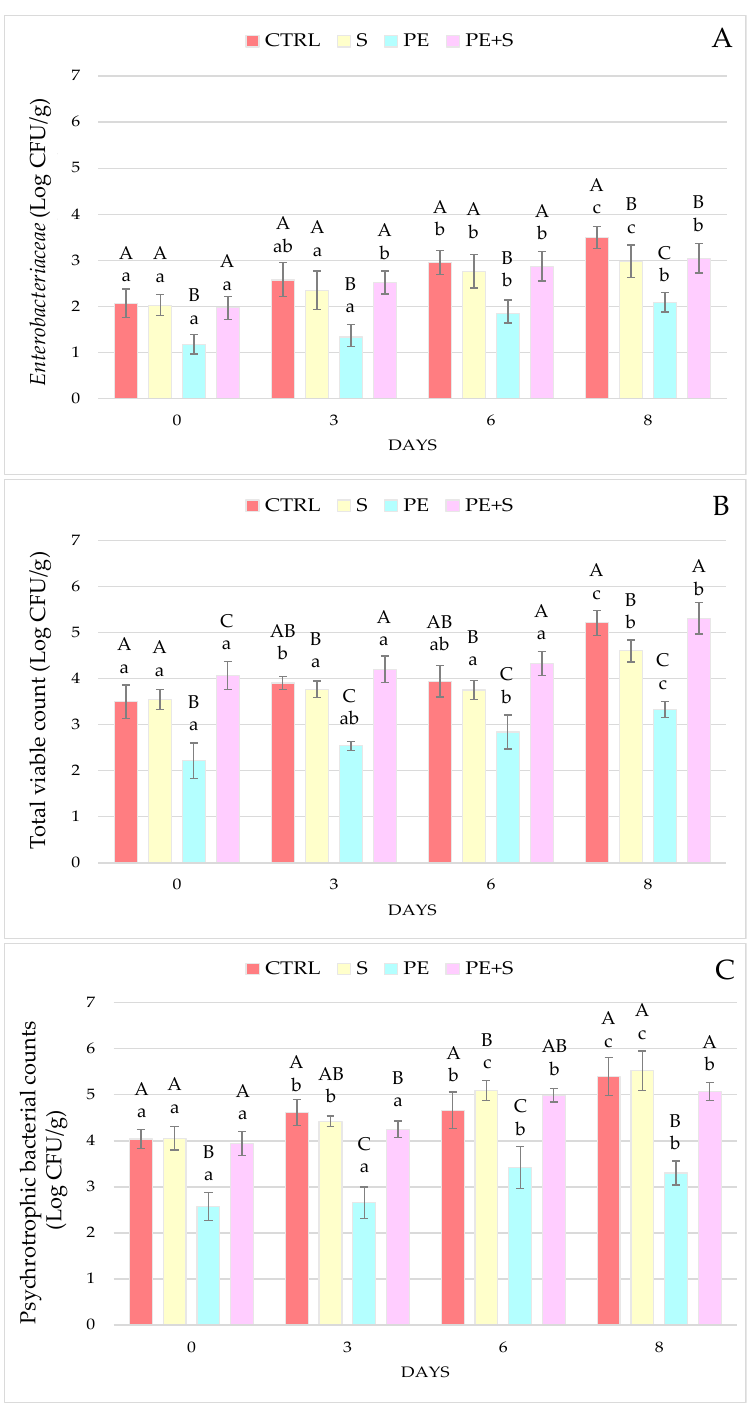
Figure 1. Microbiological changes at days 0, 3, 6, and 8 of storage, in control (CTRL), sulphites (S), phenolic extract (PE), and phenolic extract + sulphites (PE+S) shrimps. Values are means ± standard deviation. Different uppercase letters, within each day of storage, represent significant differences between groups ( p < 0.05); different lowercase letters, within each group, represent significant differences between days of storage ( p < 0.05). Enterobacteriaceae ( A ), total viable count ( B ), and psychrotrophic bacteria counts ( C ).